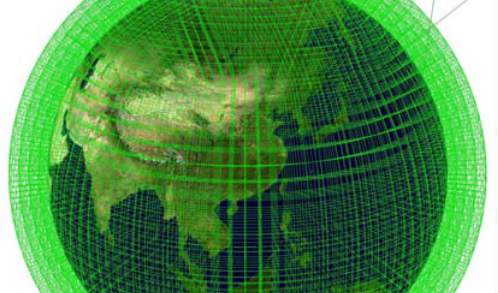
Figure 19. Sphere Shell Space 3D Grid (green wire frame) over the whole earth.